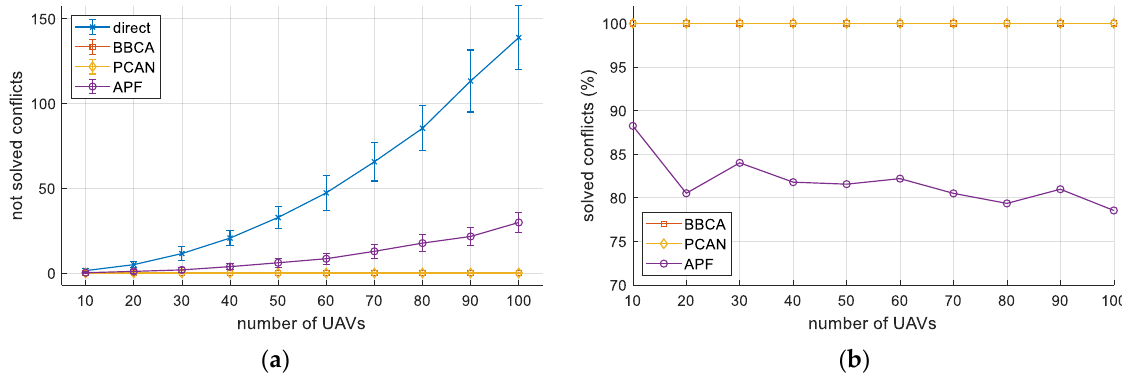
Figure 11. Multi-UAV study. The number of conflicts: ( a ) not solved conflicts (mean and standard deviation); ( b ) solved conflicts (%).